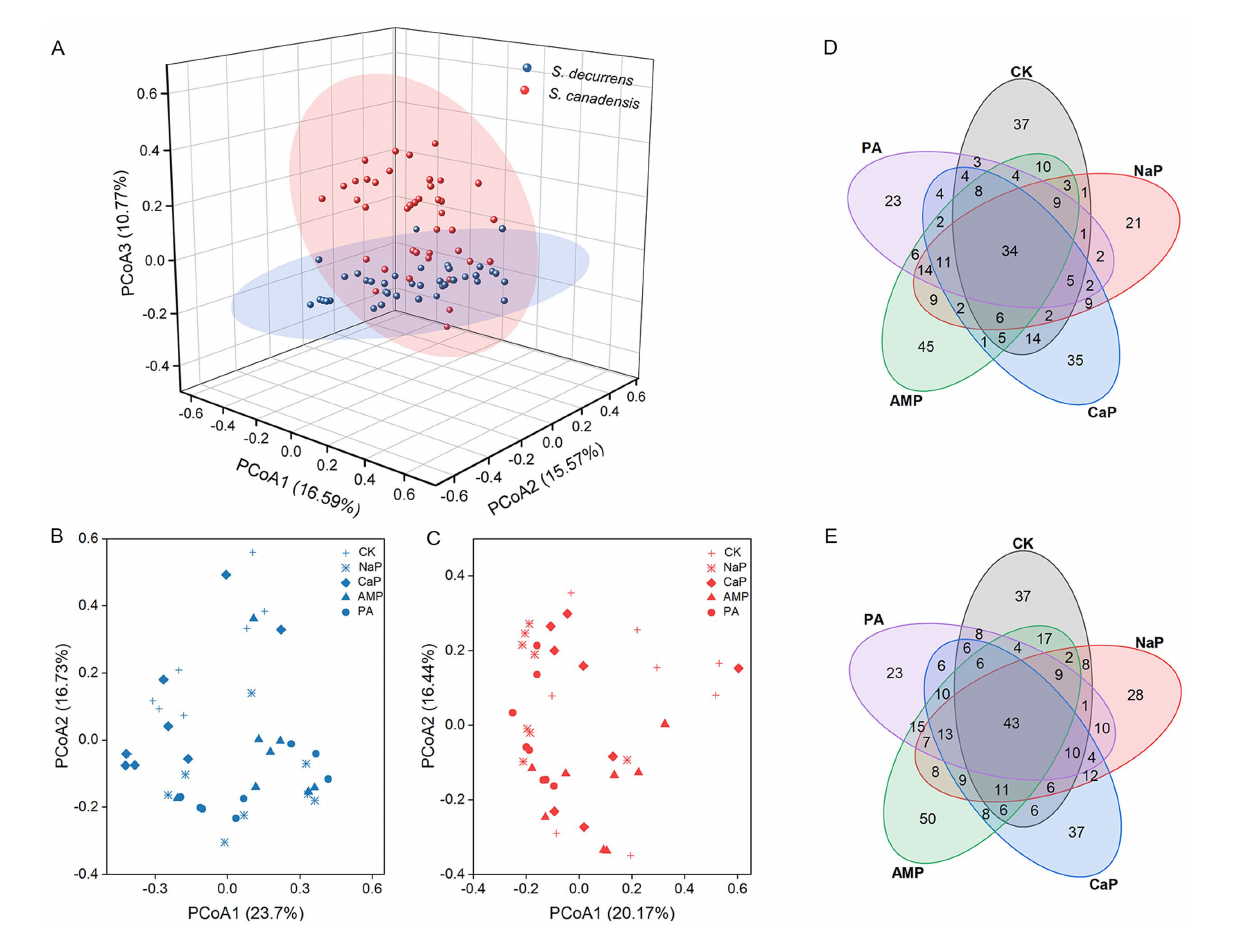
FIGURE 3 (A) Principal coordinates analysis (PCoA) based on the Bray–Curtis distance showing the differences in AMF community structure of S. decurrens and S. canadensis . Principal coordinates analysis (PCoA) based on the Bray–Curtis distance showing the difference in AMF community structure among five P treatments in (B) S. decurrens and (C) S. canadensis . CK: no P addition; NaP: sodium dihydrogen phosphate; CaP: hydroxyapatite; AMP: adenosine monophosphate; PA: myo-inositol hexakisphosphate. Venn diagrams showing the number of shared and unique ASVs among five P treatments